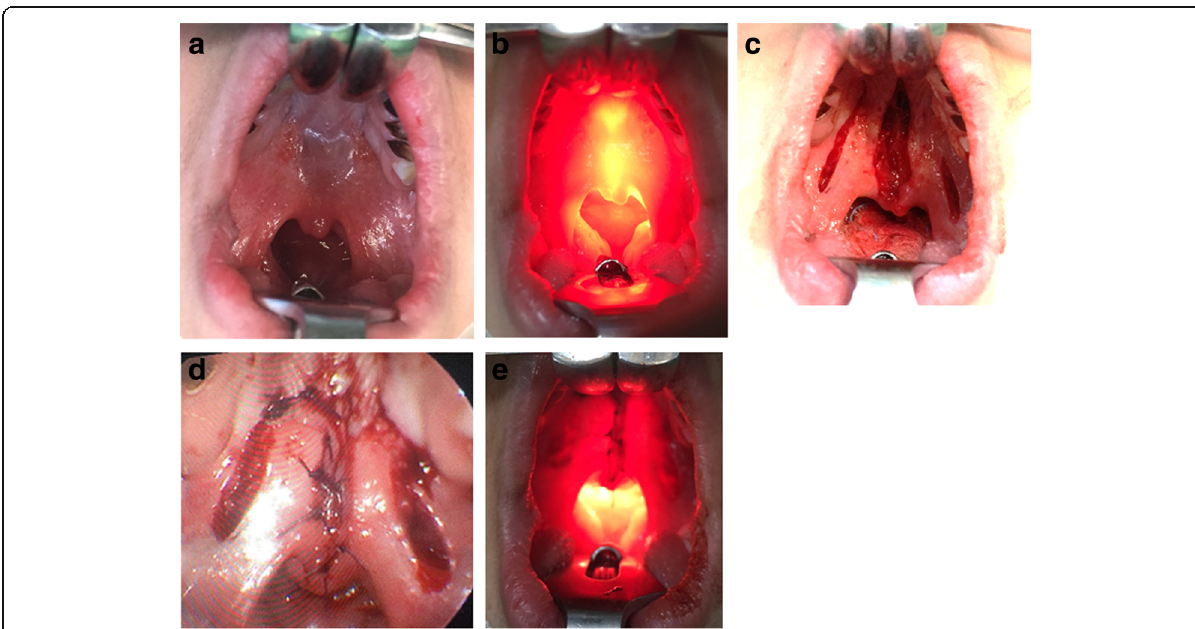
Fig. 4 a Transoral view of the bifid uvula and zona pellucida. b Transnasal transillumination of the palate showing the bifid uvula and membranous part of the palate extending to the bony part. c Transoral dissection of the central part of the palate (intersection of the palatal and nasal mucosa) with preservation of nasal mucosa showing the muscular part on both side of membranous palate with lateral release incisions (von Langenbeck technique). d Repair of the palatal muscles and mucoperiosteal flaps on the oral side with 3-0 vicryl. e Post-repair transnasal transillumination of the palate